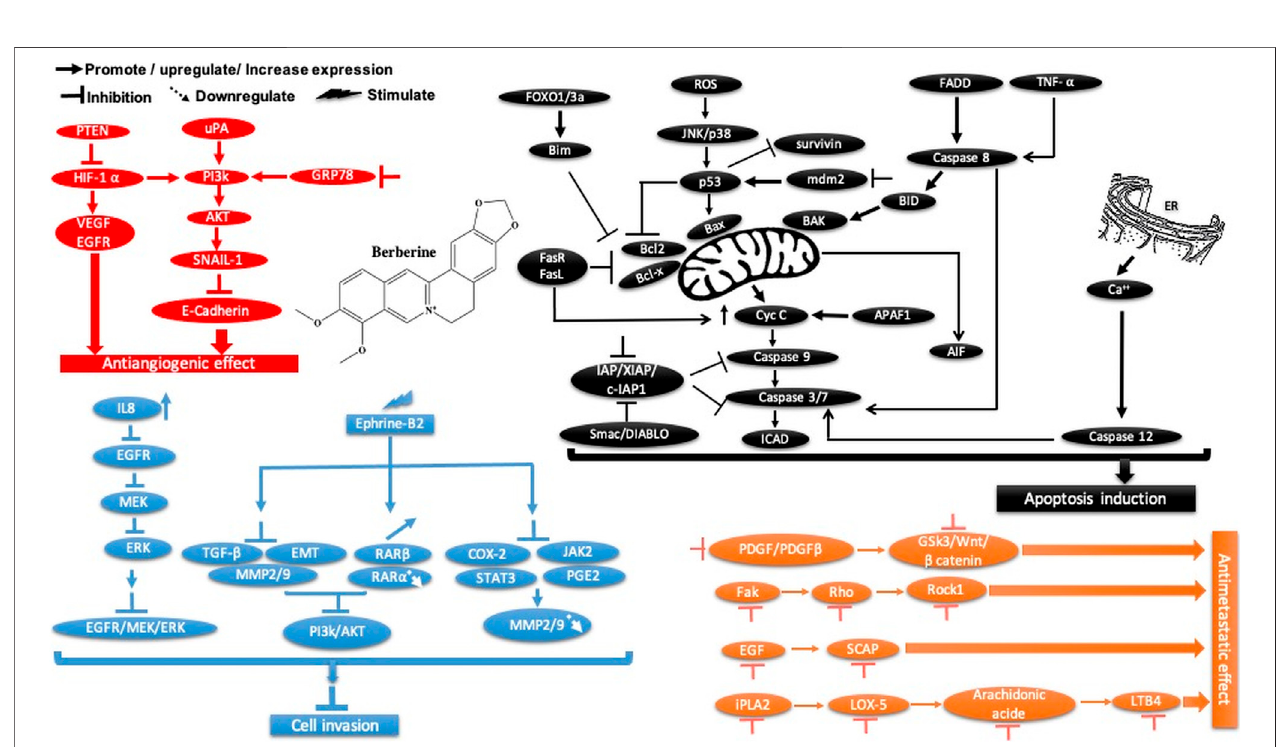
FIGURE 9 | Schematic representation of apoptotic events, cell migration, and angiogenesis inhibition of berberine against cancer.